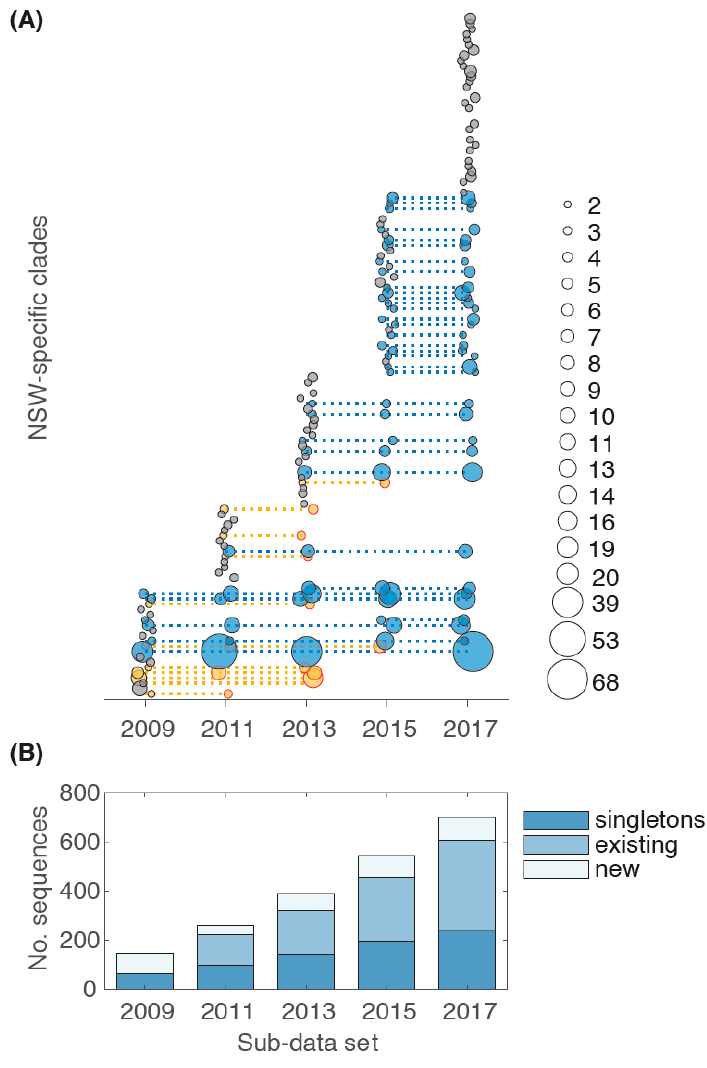
Figure 3. Discontinued and active ongoing NSW-specific clades. ( A ) Clade size for different clades is shown across the five sub-data sets. Discontinued clades are shown in orange with time period for the most recent sequence sampled shown with a red circle, sustained ongoing clades in blue, all other clades in black. Clade size for the analyzed time frame is indicated in the legend. ( B ) The number of singleton sequences is shown for the five different sub-data sets (dark blue). For each sub-data set new sequences belonging to an existing clade (blue) from the previous sub-data set, and new sequences forming a new clade (grey), are also shown. The x-axis defines the sequence sampling date grouped into the two-year time periods investigated.